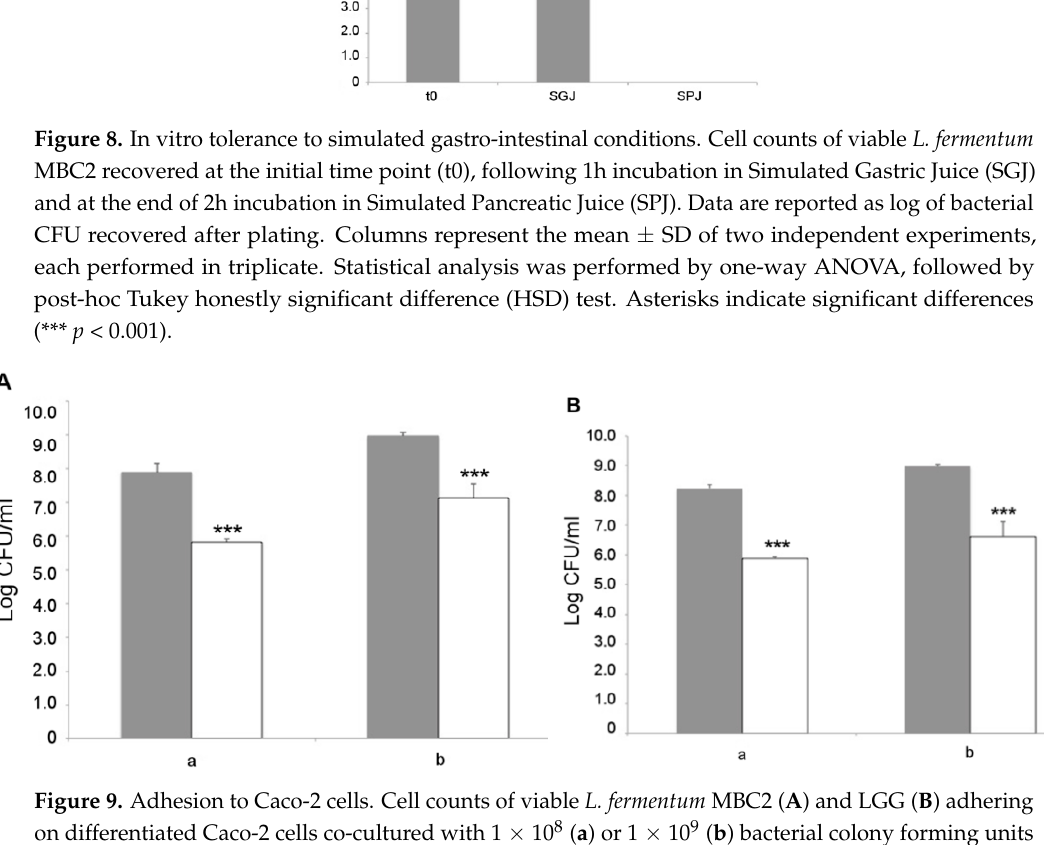
Figure 9. Adhesion to Caco-2 cells. Cell counts of viable L. fermentum MBC2 ( A ) and LGG ( B ) adhering on differentiated Caco-2 cells co-cultured with 1 × 10 8 ( a ) or 1 × 10 9 ( b ) bacterial colony forming units (CFU)/well. Grey columns refer to the initial bacterial load, while white columns refer to adhering bacteria recovered at the end of co-incubation. Data are reported as log of bacterial CFU recovered after plating. Columns represent the mean ± SD of two independent experiments, each performed in triplicate. Statistical analysis was performed by one-way ANOVA, followed by post-hoc Tukey honestly significant difference (HSD) test. Asterisks indicate significant differences (*** p < 0.001). Table 1. Antibiotic susceptibility of L. fermentum MBC2 and LGG strains.